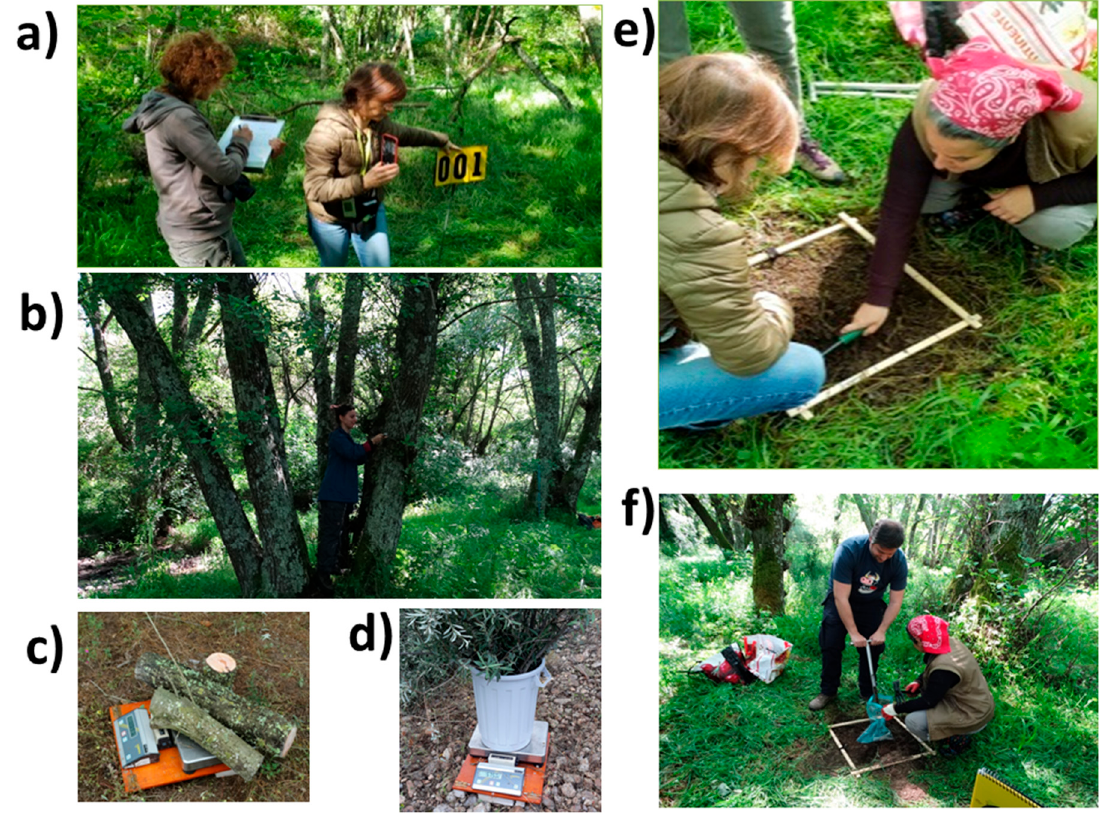
Figure 2. Examples of the field-work methodology: ( a ) georeferencing of the sampling plot central point, ( b) diameter at breast height (DBH) measurements in the distinct stems of an Alnus glutinosa tree, ( c , d ) collection of the total aboveground fresh weight using the harvesting method, ( e ) collection of the understory biomass, ( f ) collection of the carbon in the mineral soil layer.